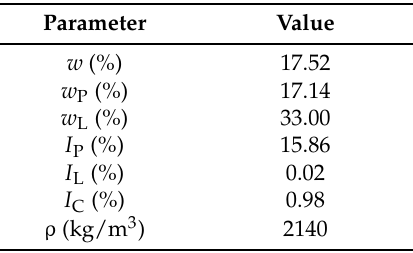
Table 1. Basic properties of the tested